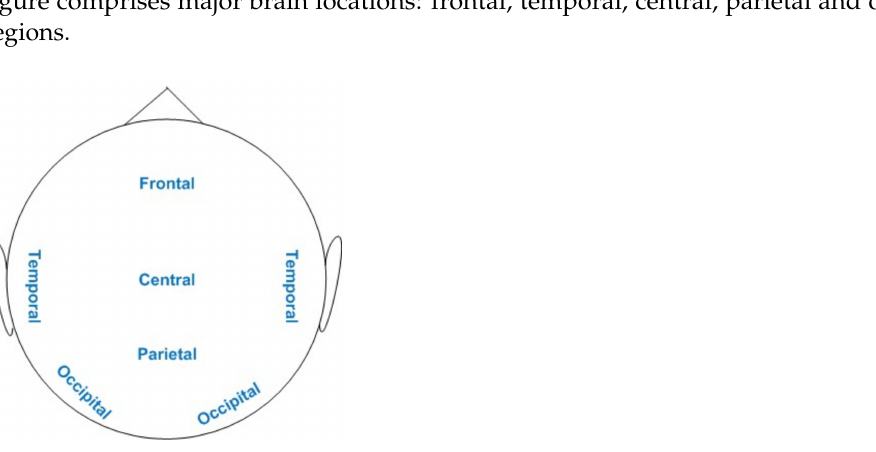
Figure 5. Different locations/regions in the human brain.